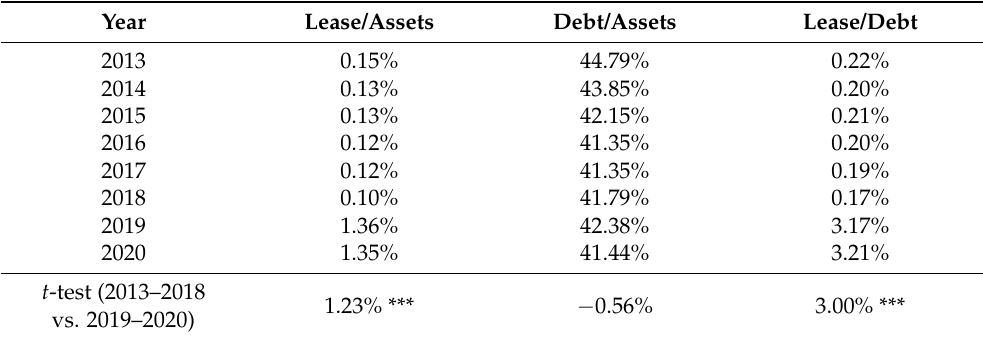
Table 1. The average lease liabilities-to-assets ratios (Lease/Assets), total liabilities-to-assets ratios (Debt/Assets), and lease liabilities-to-total liabilities (Lease/Debt) by year. *** denote statistical significance at the 1% level.